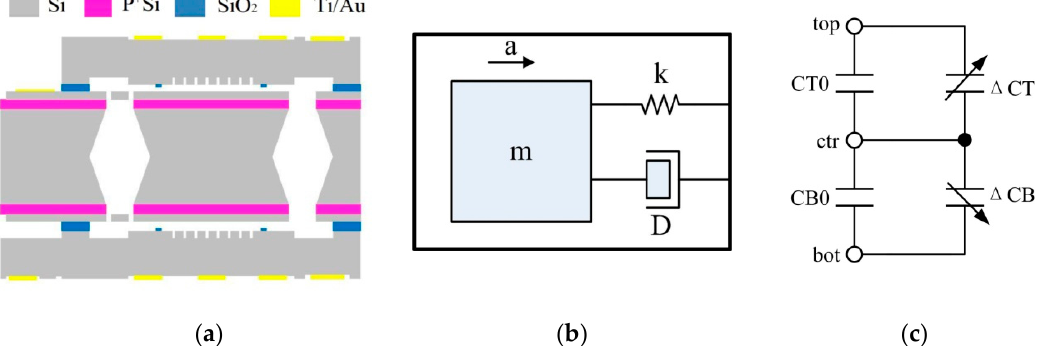
Figure 3. ( a ) Structure of the sandwich-type accelerometer; ( b ) 2nd order model of the mechanical device; ( c ) Equivalent circuit of the mechanical